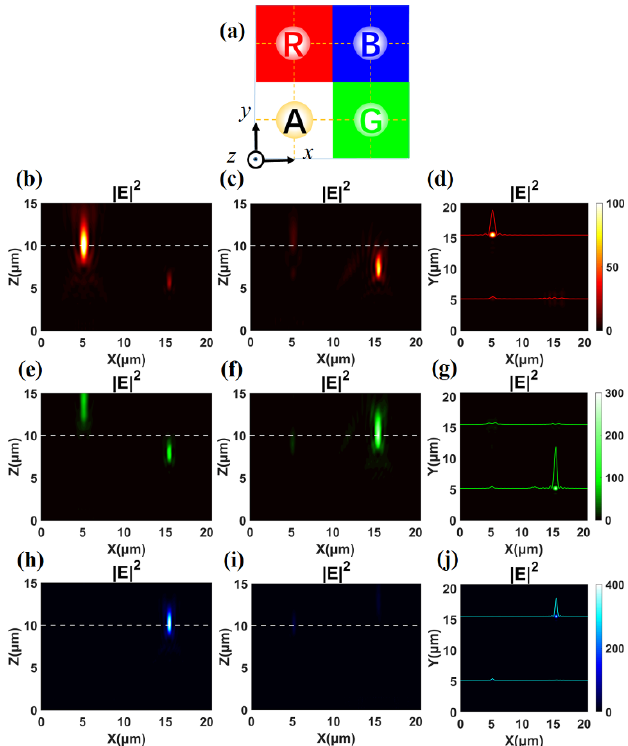
Figure 5. ( a ) Schematic diagram of the theta modulation meta ‐ surface with four equal areas. ( b – d ) Electric field intensity profiles in the focal region of the xz plane with y = 15.48 μ m, xz plane with y = 5.16 μ m, and xy plane z = 10.00 μ m, respectively, at λ = 700 nm. The white dash lines mark the position of z = 10.00 μ m in the xz planes. The normalized intensity distributions along the horizontal ( x ) line through the center of the focus are noted. ( e – g ), ( h – j ) Corresponding analysis of panels ( b – d ) for a meta ‐ surface at λ = 513 nm and λ = 405 nm.